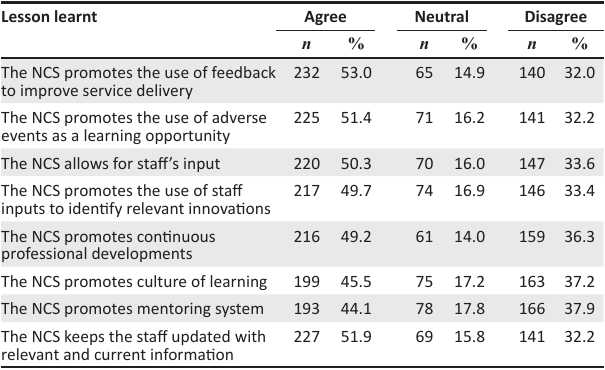
Core Standards tool. Lesson learnt